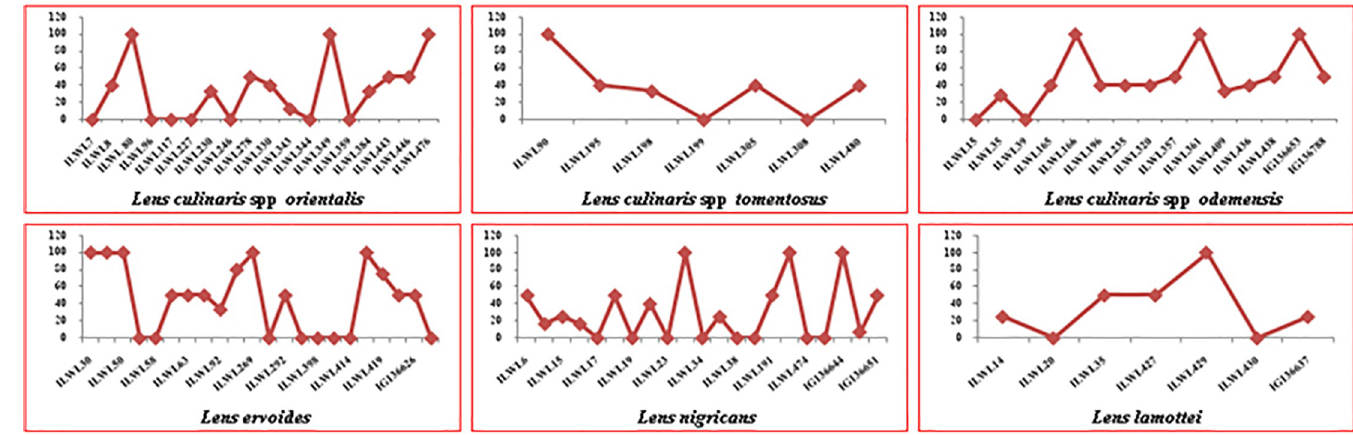
Fig 6. Screening of wild lentil accessions against Fusarium wilt